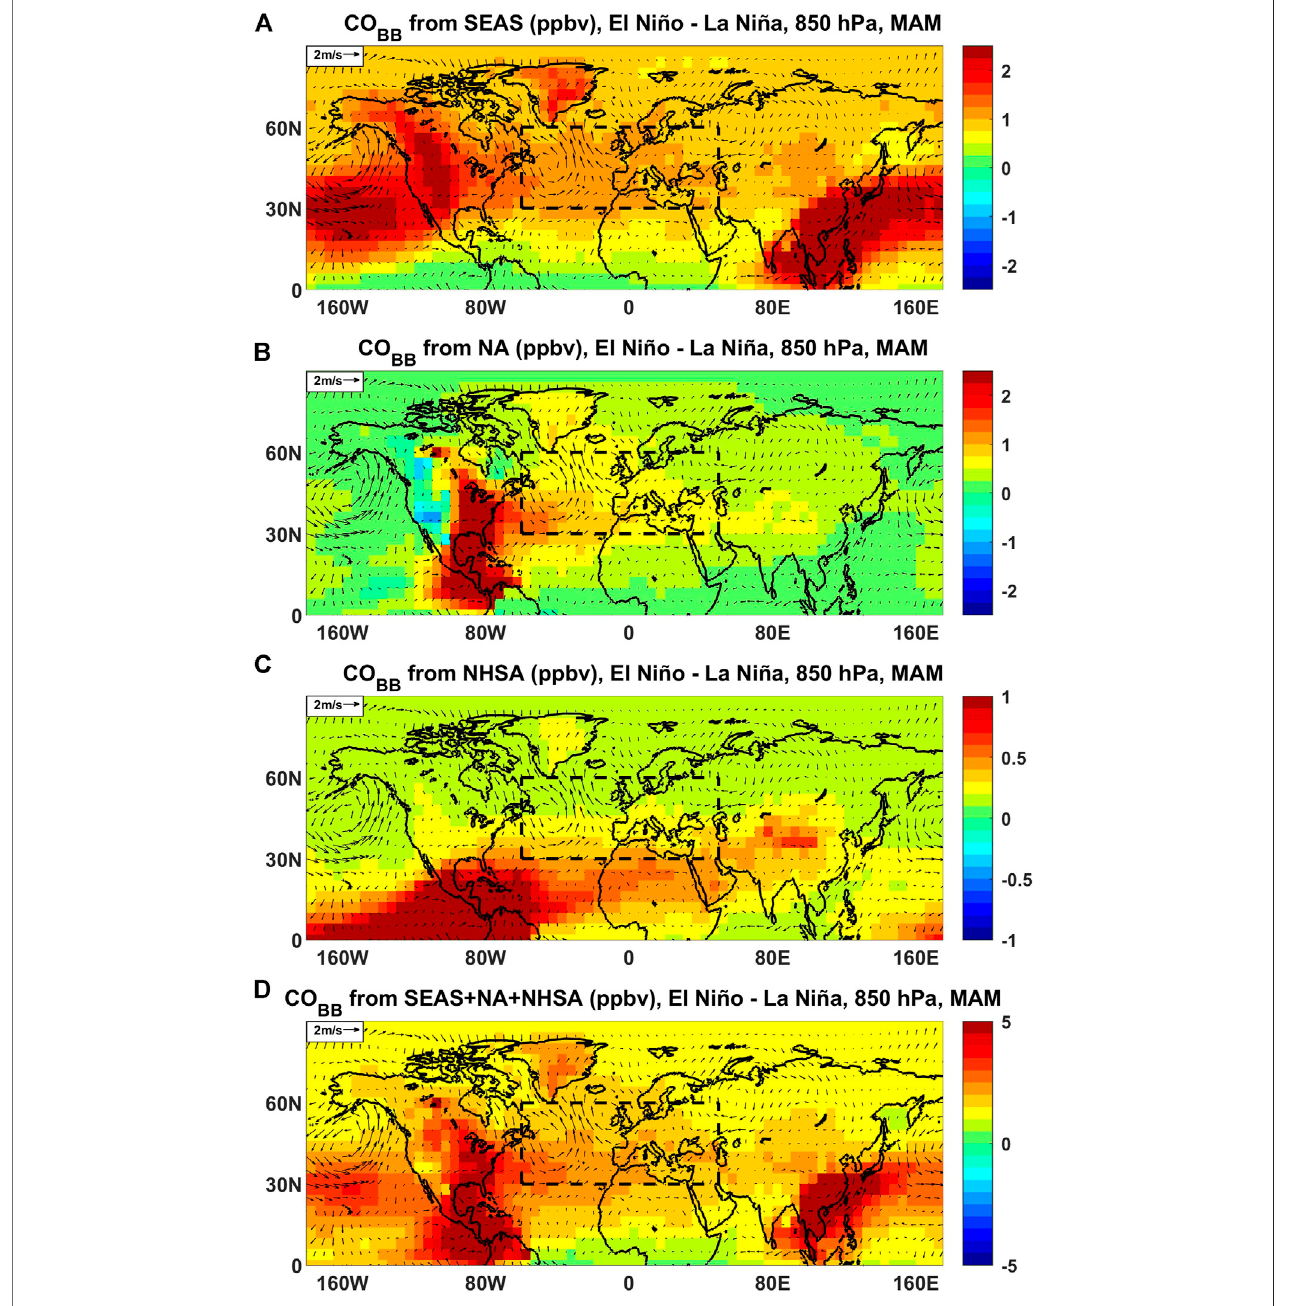
FIGURE 6 | The same as Figure 5 , but for the differences in CO BB concentrations and wind between El Niño and La Niña years.